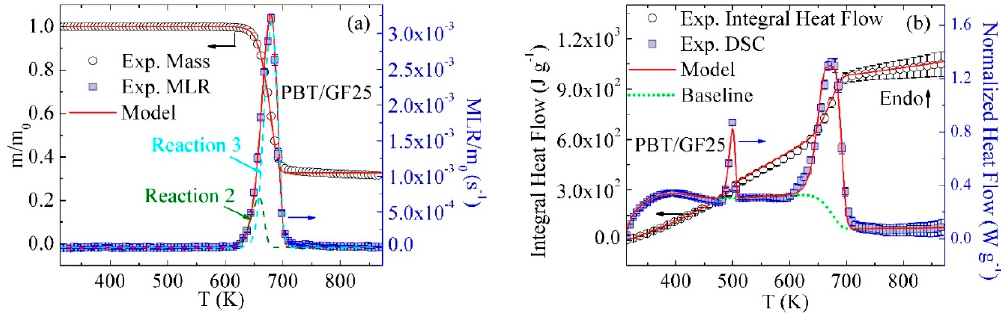
Figure 2. Experimental and simulated ( a ) TGA and ( b ) DSC data obtained for PBT/GF25 at 10 K · min − 1 .